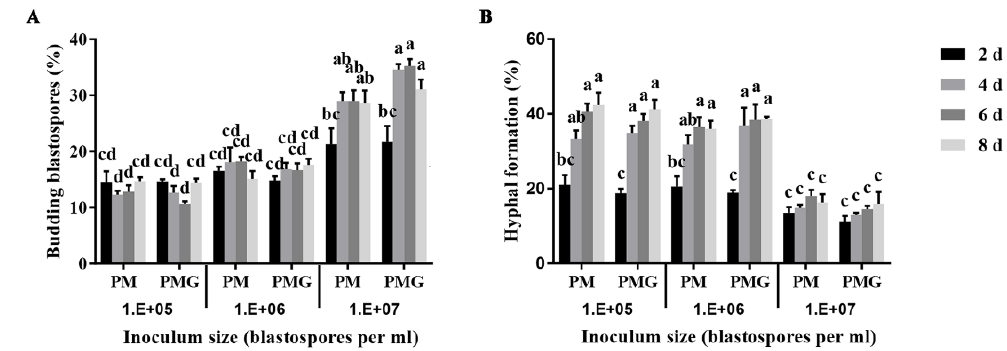
Figure 2. Effects of inoculum density on blastospores budding growth ( A ) and hyphal formation ( B ) of Ophiocordyceps sinensis in liquid PM and PMG culture media. Different letters indicated the significant levels at p < 0.05.